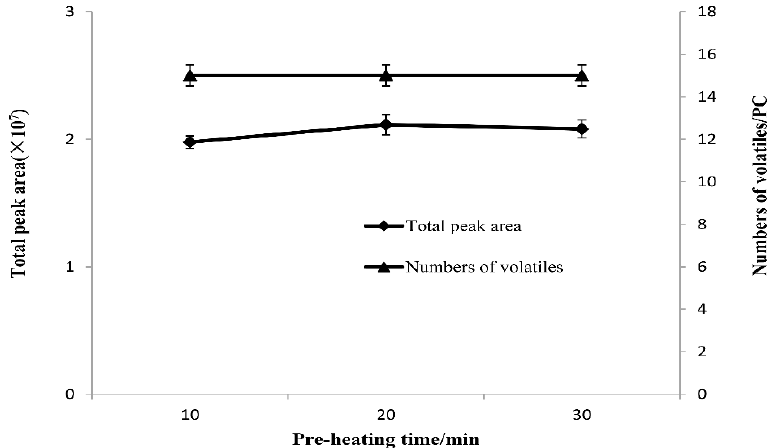
Figure 4. Effect of pre heating time on total peak area and numbers of volatiles from stink tofu brine.